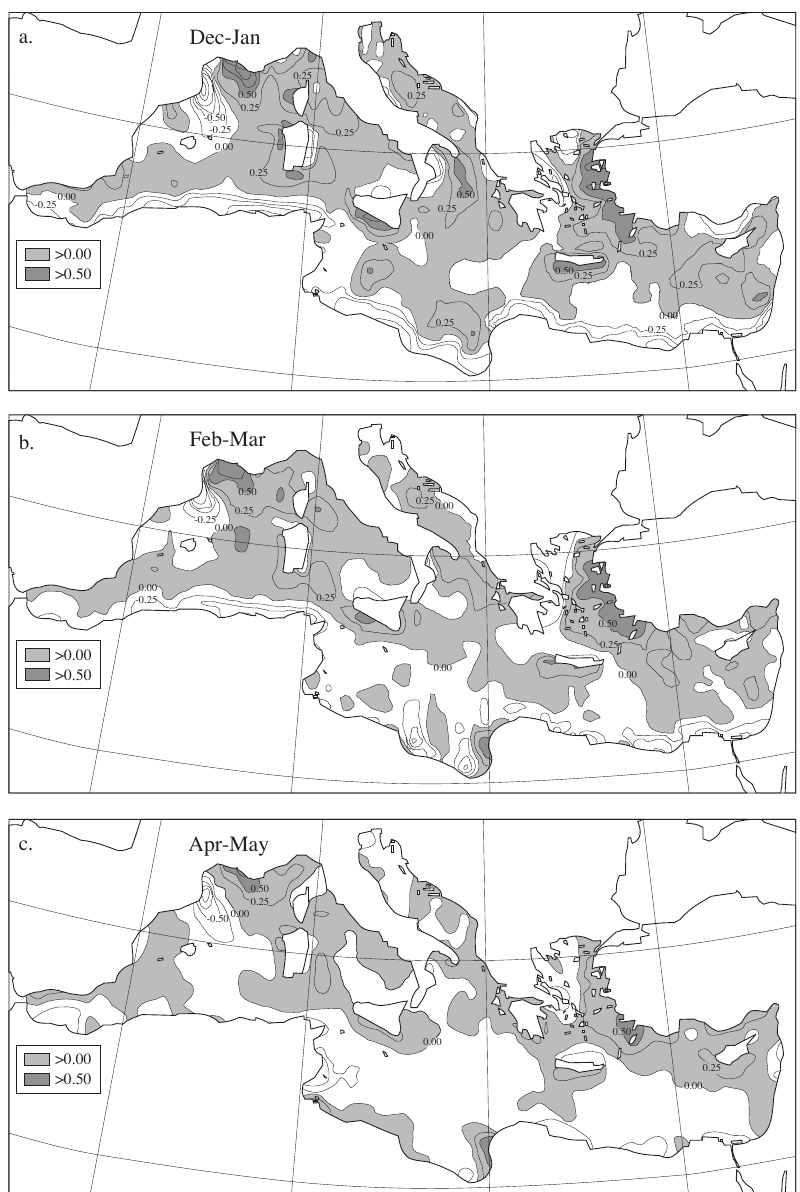
F IG . 4. – Seasonal variation of computed vertical velocities at the bottom of the surface Ekman layer. Units are meters per day. Contour inter- val is 0.25. Shaded areas indicate zones of upwelling. Darker shading indicates upward velocities greater than 0.5 m/day. Unshaded areas indicate zones of downwelling. (a) Dec-Jan. (b) Feb-Mar. (c) Apr-May. (d) Jun-Jul. (e) Aug-Sep. (f)